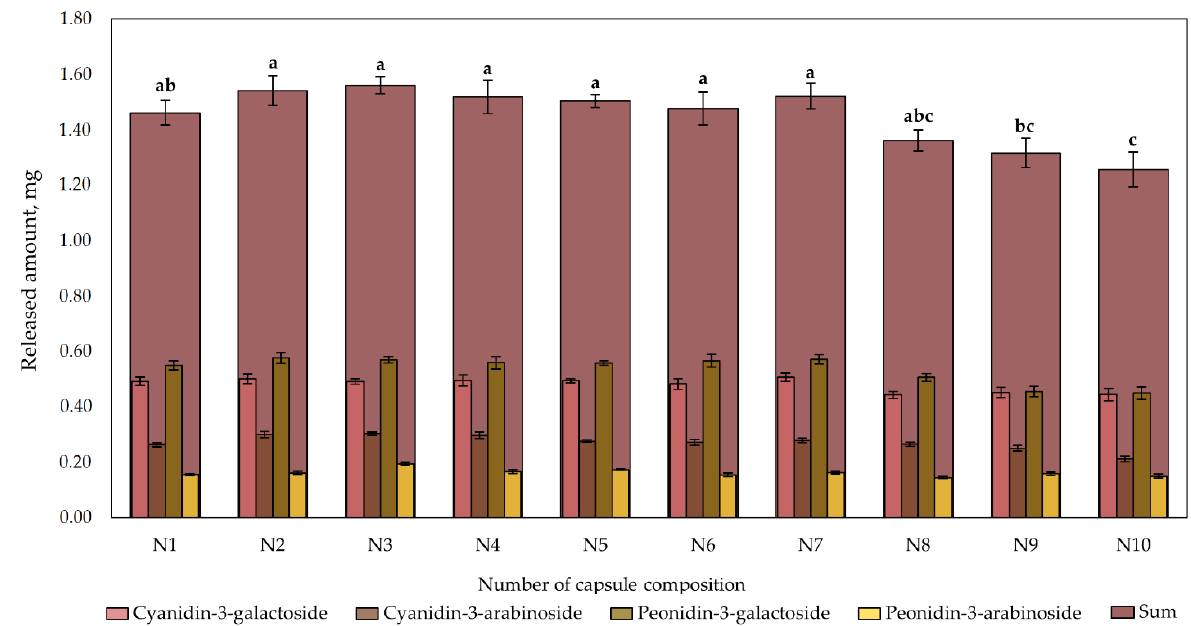
Figure 6. Content of the individual anthocyanins and their sum released from cranberry lyophilizate- containing capsules of different composition after 90 min. The compositions of the capsules (N1–N10) are described in Table 1. Different letters indicate significant differences ( p < 0.05) between sum amounts of anthocyanins in the tested capsule formulations, and capsule formulations with same letter were not significantly different ( p > 0.05).